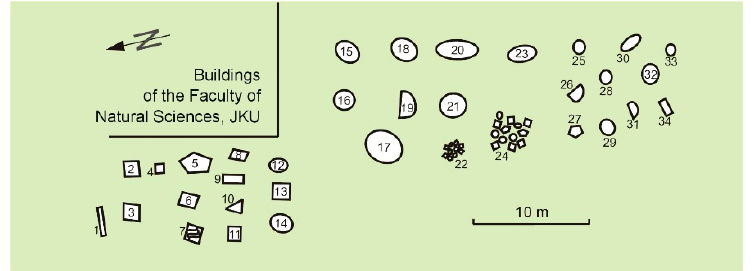
Figure 7. Schematic distribution map of specimens in the IGES Rock Garden .